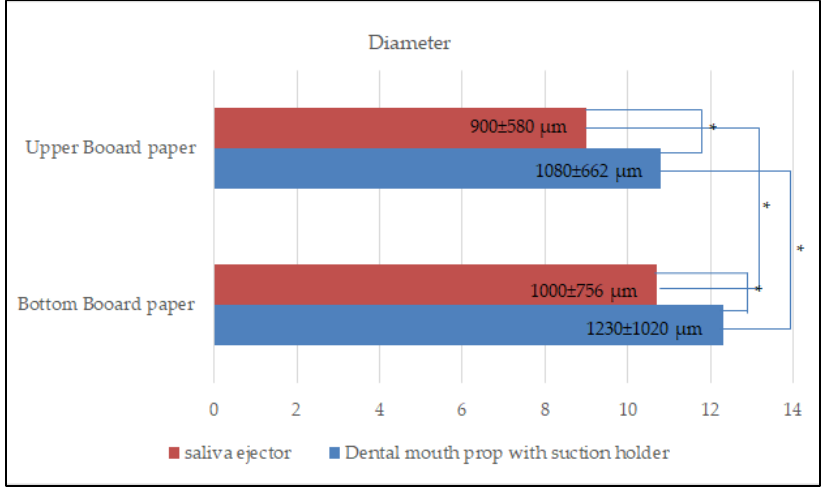
Figure 4. Bar chart showing the difference in the mean diameter of aerosol and splatter particles between upper board paper and bottom board paper when using a saliva ejector and a dental mouth prop with a suction holder. * Statistical significance at p < 0.001.